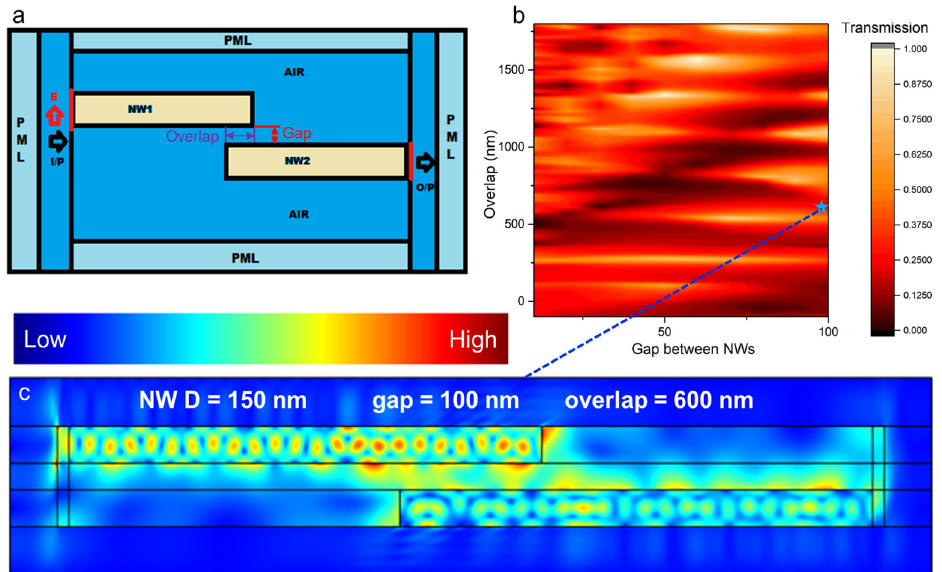
Figure 4. Simulation of the light propagation through displaced GaP NWs: ( a ) model geometry, ( b ) colormap showing normalized transmission for different gap and lateral overlap, and ( c ) nor- malized E-field distribution plot showing coupling of two 2 µ m NWs separated by 100 nm gap and overlapped by 600 nm.